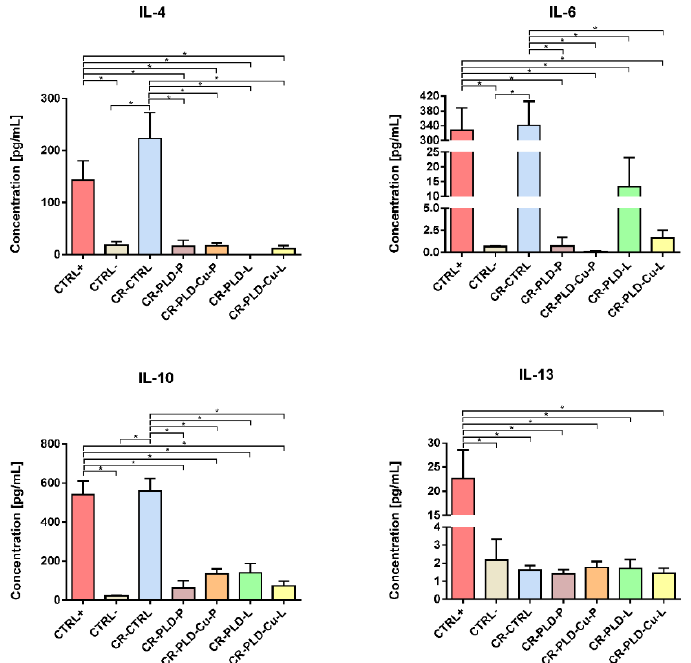
Figure 3. Cytokine release by human monocytes (THP-1 cells) assessed by ELISAs; CTRL+-positive control in the form of cells stimulated with pro-inflammatory factors (LPS, INF- γ ), CTRL − -negative control in the form of untreated cells cultured on polystyrene well; * statistically significant ( p < 0.05) results between indicated group according to One-way ANOVA with post-hoc Tukey